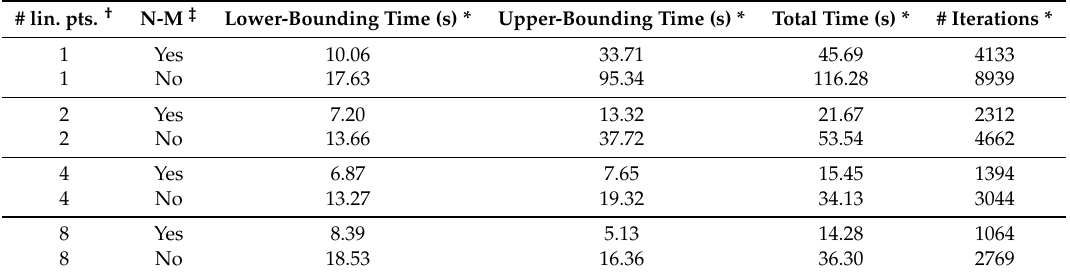
Table 7. The solution statistics for our implementation applied to (11).